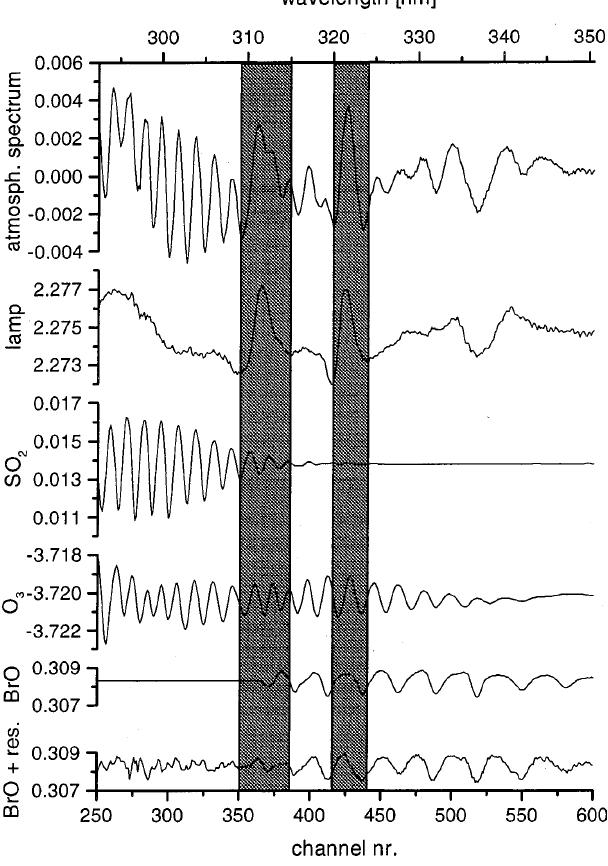
Fig. 1. Air spectrum in the wavelength region 293–350 nm, path length 4200 m ( trace a ). The fitted spectral absorption intensities correspond to atmospheric trace gas absorptions of 30 ppb O 3 ( d ), 1 ppb SO 2 ( c ) and 9 ppt BrO ( e ). The shaded areas cover large lamp structures ( b ) and were excluded from the fit. Trace f shows the atmospheric BrO spectrum obtained from the air spectrum by taking out the fitted lamp structures and species absorptions of SO 2 and O